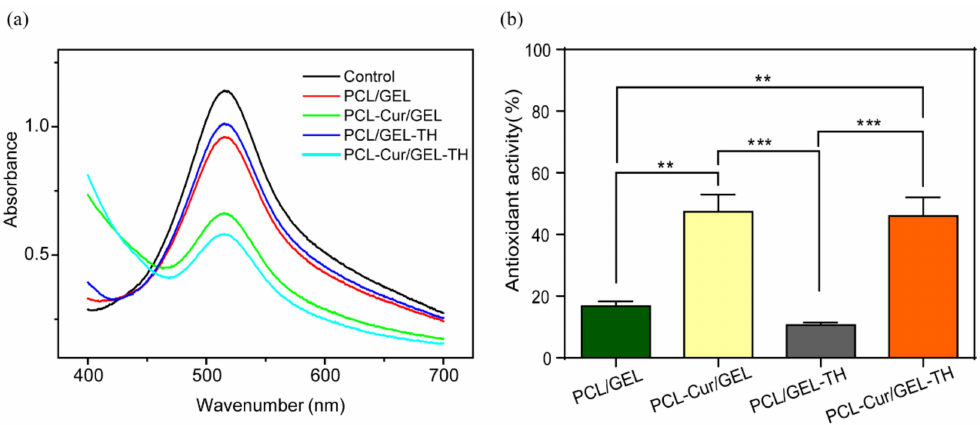
Figure 5. ( a ) Absorbance of DPPH solution with different nanofibrous membranes. ( b ) DPPH scavenging activity of different nanofiber membranes. ** p < 0.01; *** p <